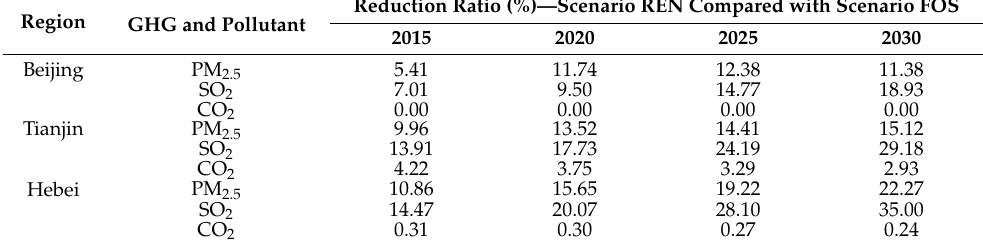
Table 4. Sensitivity analysis of pollutant reduction.